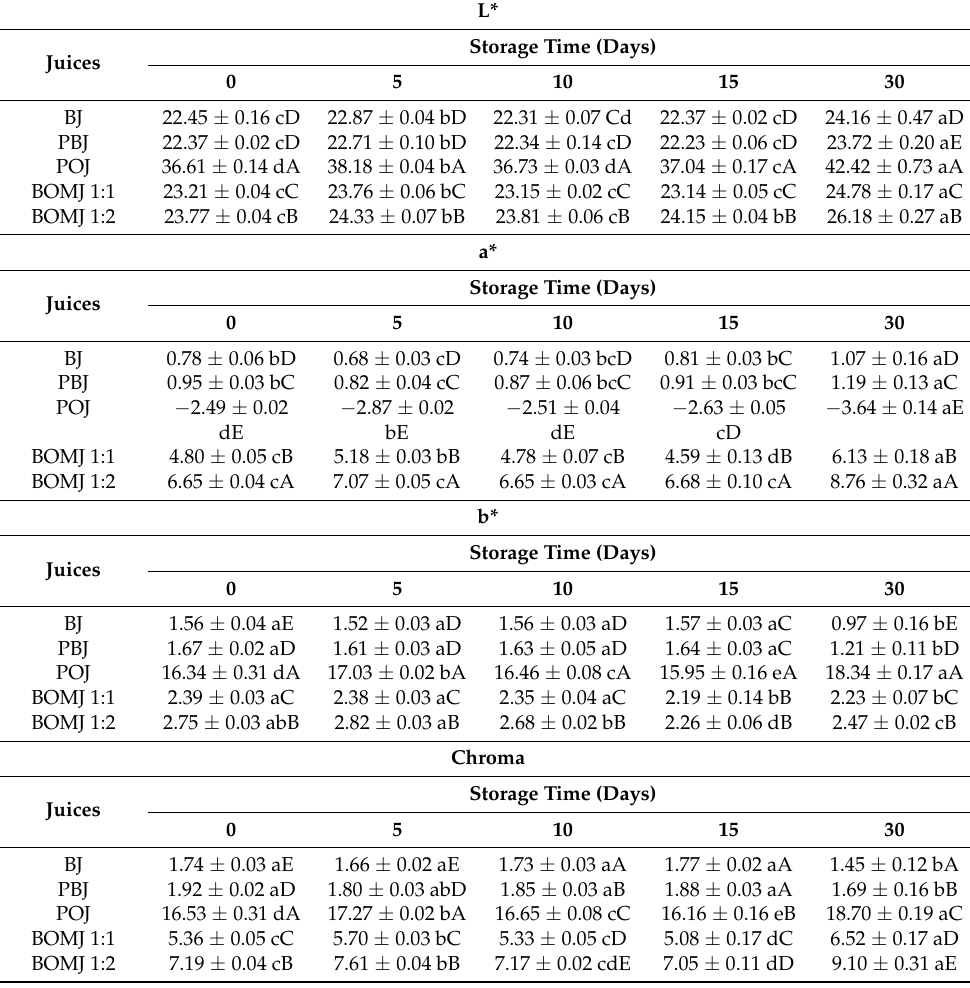
Table 2. Color parameters for juices stored at 4 °C for 30 days